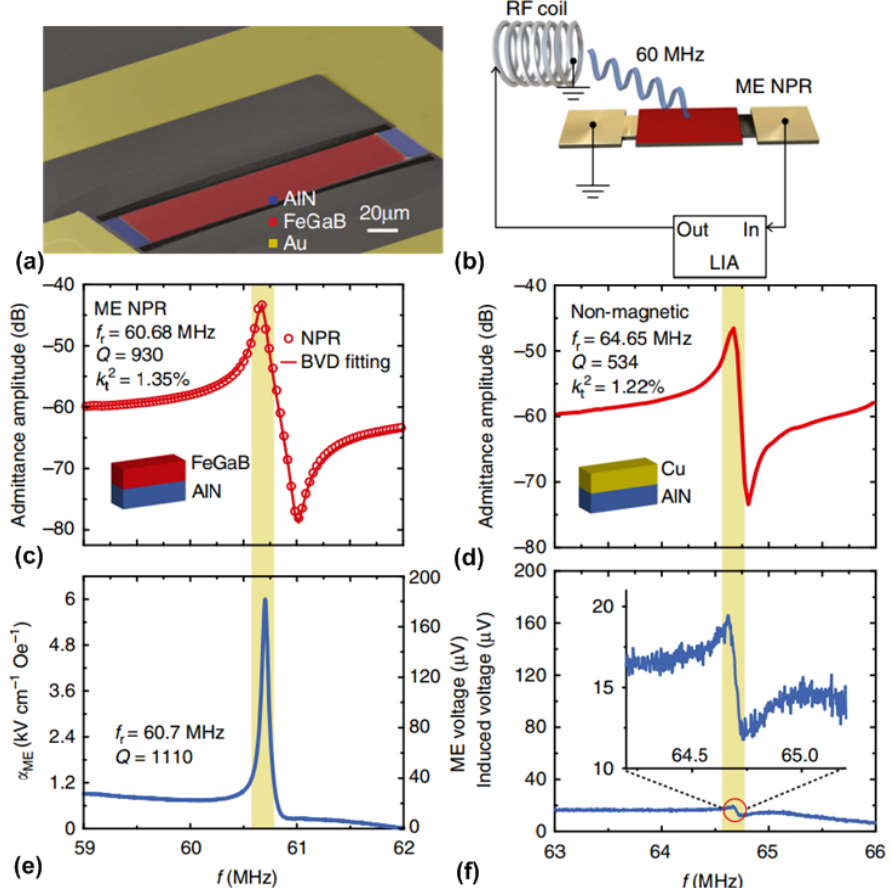
Figure 9. ( a ) SEM of the NPR-type mechanical antenna; ( b ) schematic of the measurement setup